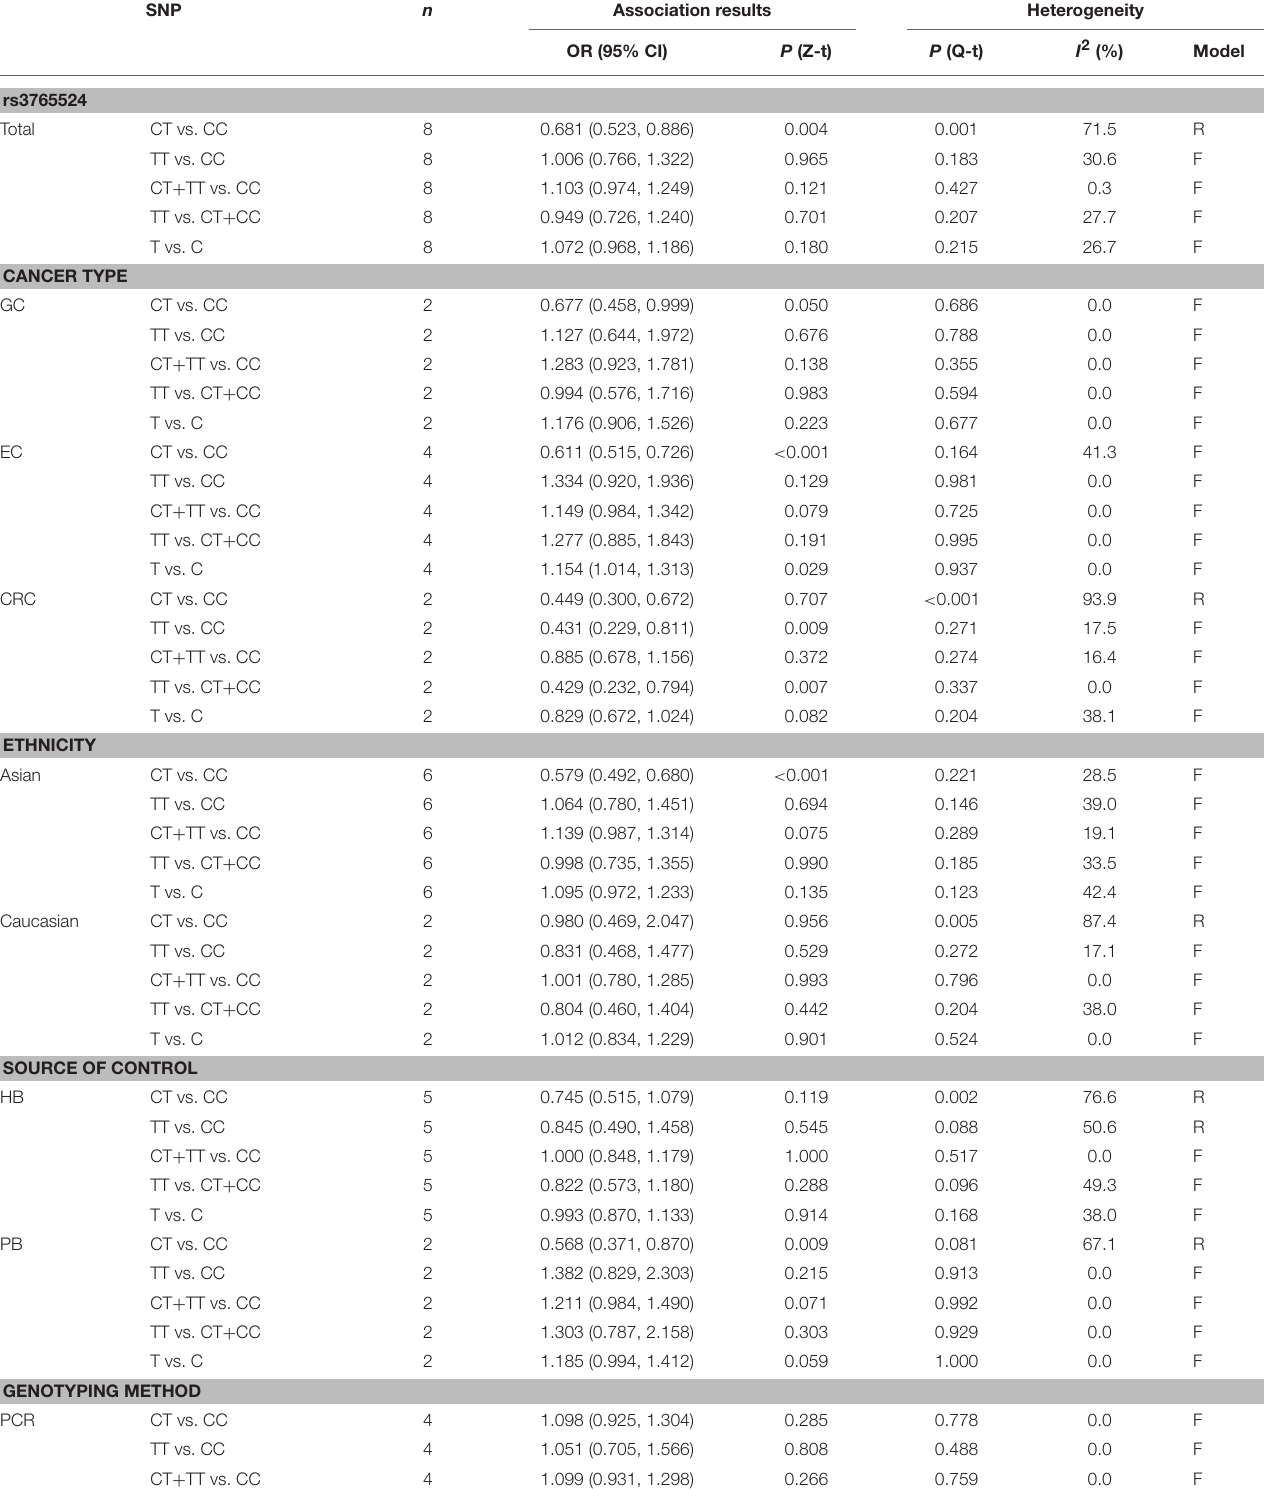
TABLE 3 | Meta-analysis of the association between PLCE1 rs3765524 polymorphism and cancer